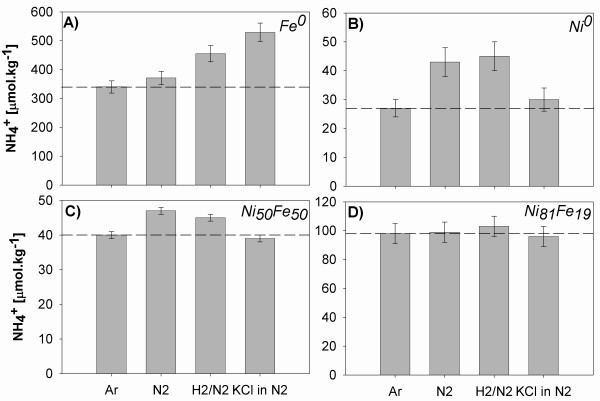
NH4+ formation from N2 in the presence of Ni, Fe metals and alloys at 200°C. The dashed lines correspond to the Ar blank. The concentrations of KCl in the experiments were 459 μmol.kg-1 in A, B and 476 μmol.kg-1 in C, D. Results are normalized to 1 m2 of surface area.